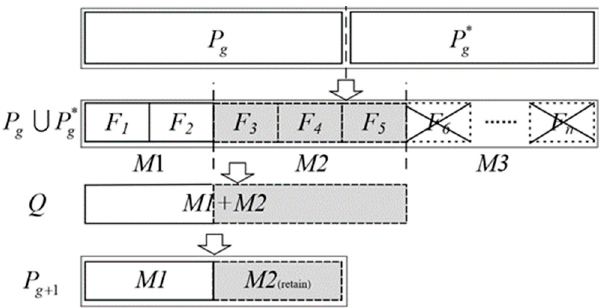
Figure 1. DNSGA algorithm workflow chart.